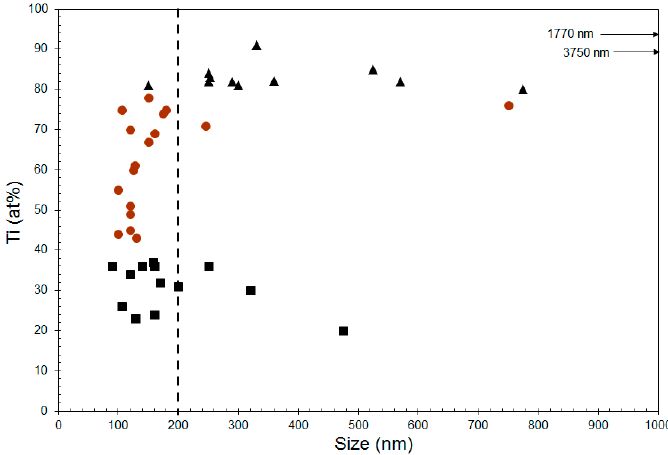
Figure 6. Ti composition vs precipitate size, measured by EDX analysis, for the Group 1–3 precipitates.